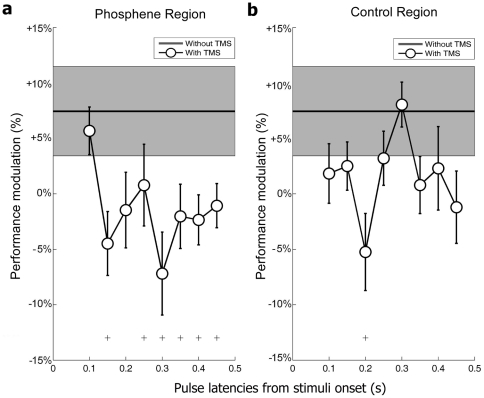
TMS latency effects on serial search (L versus T).The variations in performance are plotted as a function of pulse latency. The zero baseline corresponds to the mean hit rate across both TMS conditions (phosphene and control regions) and across all pulse latencies. Error bars represent standard error of the mean (SEM). The condition “without TMS” (also normalized with respect to the same baseline) is indicated by the horizontal line and shaded area (mean ± SEM); the hit rate without TMS was about 7% higher on average than in the TMS conditions. The symbol ‘+’ denotes a significant difference (paired t-test, p<0.05) between the hit rate observed at a given pulse latency and the hit rate without TMS (these differences did not remain significant after Bonferroni's correction for multiple comparisons). a. Mean of 12 subjects' hit rates in the serial task over the “phosphene region” condition. Lower hit rates than in the no-TMS condition are observed at 6 pulse latencies, including one cluster of 5 consecutive pulse latencies (250–450 ms). A cluster analysis based on a bootstrapping procedure demonstrates that the presence of a significant performance decrease for 5 consecutive latencies is unlikely to be due to chance (p<0.05). b. Mean of 12 subjects' hit rates in the serial task, over the “control region” condition. Only one pulse latency (200 ms) generated a significant difference between the TMS and no TMS conditions. No cluster was significant.